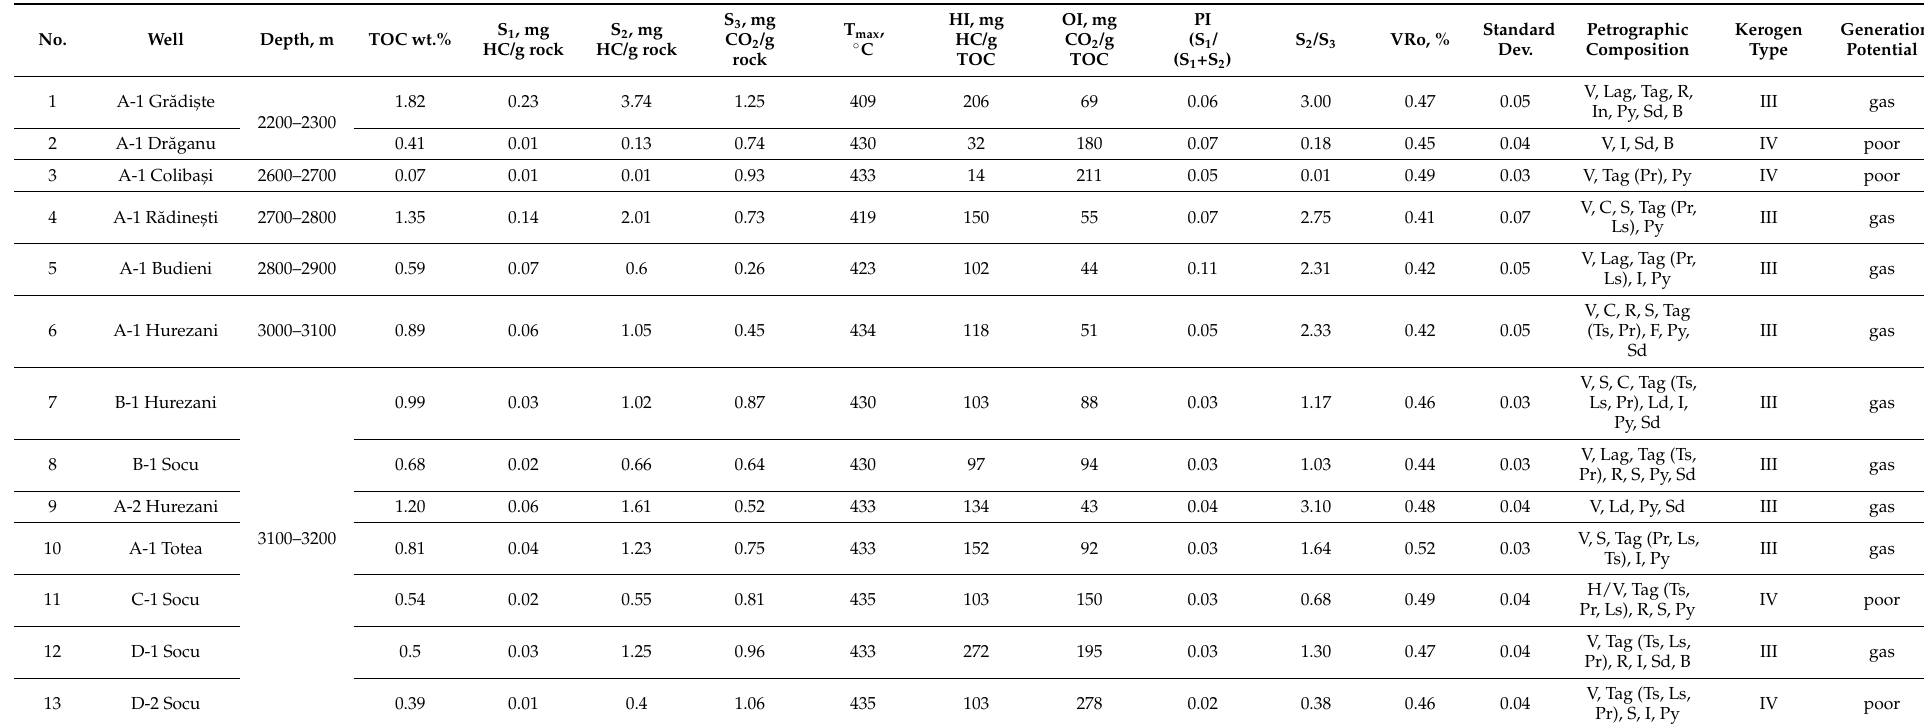
Table 1. Geochemical results of Rock-Eval analysis and vitrinite reflectance of Badenian Source Rock from Central-Southern part of the Getic Depression. Abbreviations and Acronyms: VRo%—measured vitrinite reflectance; TOC—total organic carbon of the rock sample, automatically calculated and recorded in weight ratio (wt.%); S 1 —amount of free hydrocarbons from the rock samples (mg HC/g rock); S 2 —remaining hydrocarbons generation potential of the source rock (mg HC/g rock); S 3 —oxygen compounds, amount of CO 2 from organic source (mg CO 2 /g rock); Tmax-temperature of maximum hydrocarbon generation from a rock sample during pyrolysis analysis ( ◦ C); HI—Hydrogen Index (HI = S 2 /TOC)—the amount of hydrogen relative to the amount of organic carbon present in